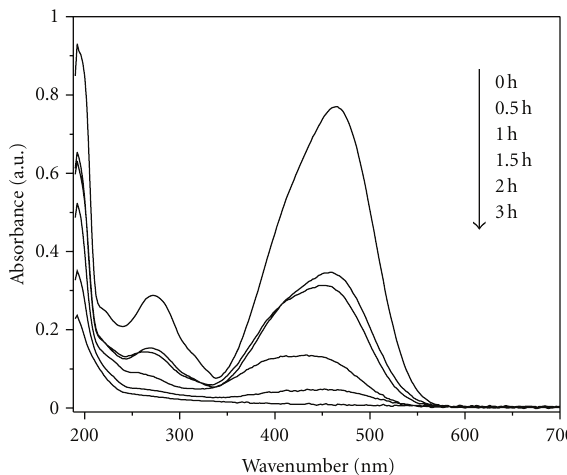
Figure 8: The UV-Vis spectra of MO during photocatalytic degra- dation on TiO 2 -Al 2 O 3 oxides prepared at C PEG1000 = 0.03 mol/L. Photocatalyst concentration was